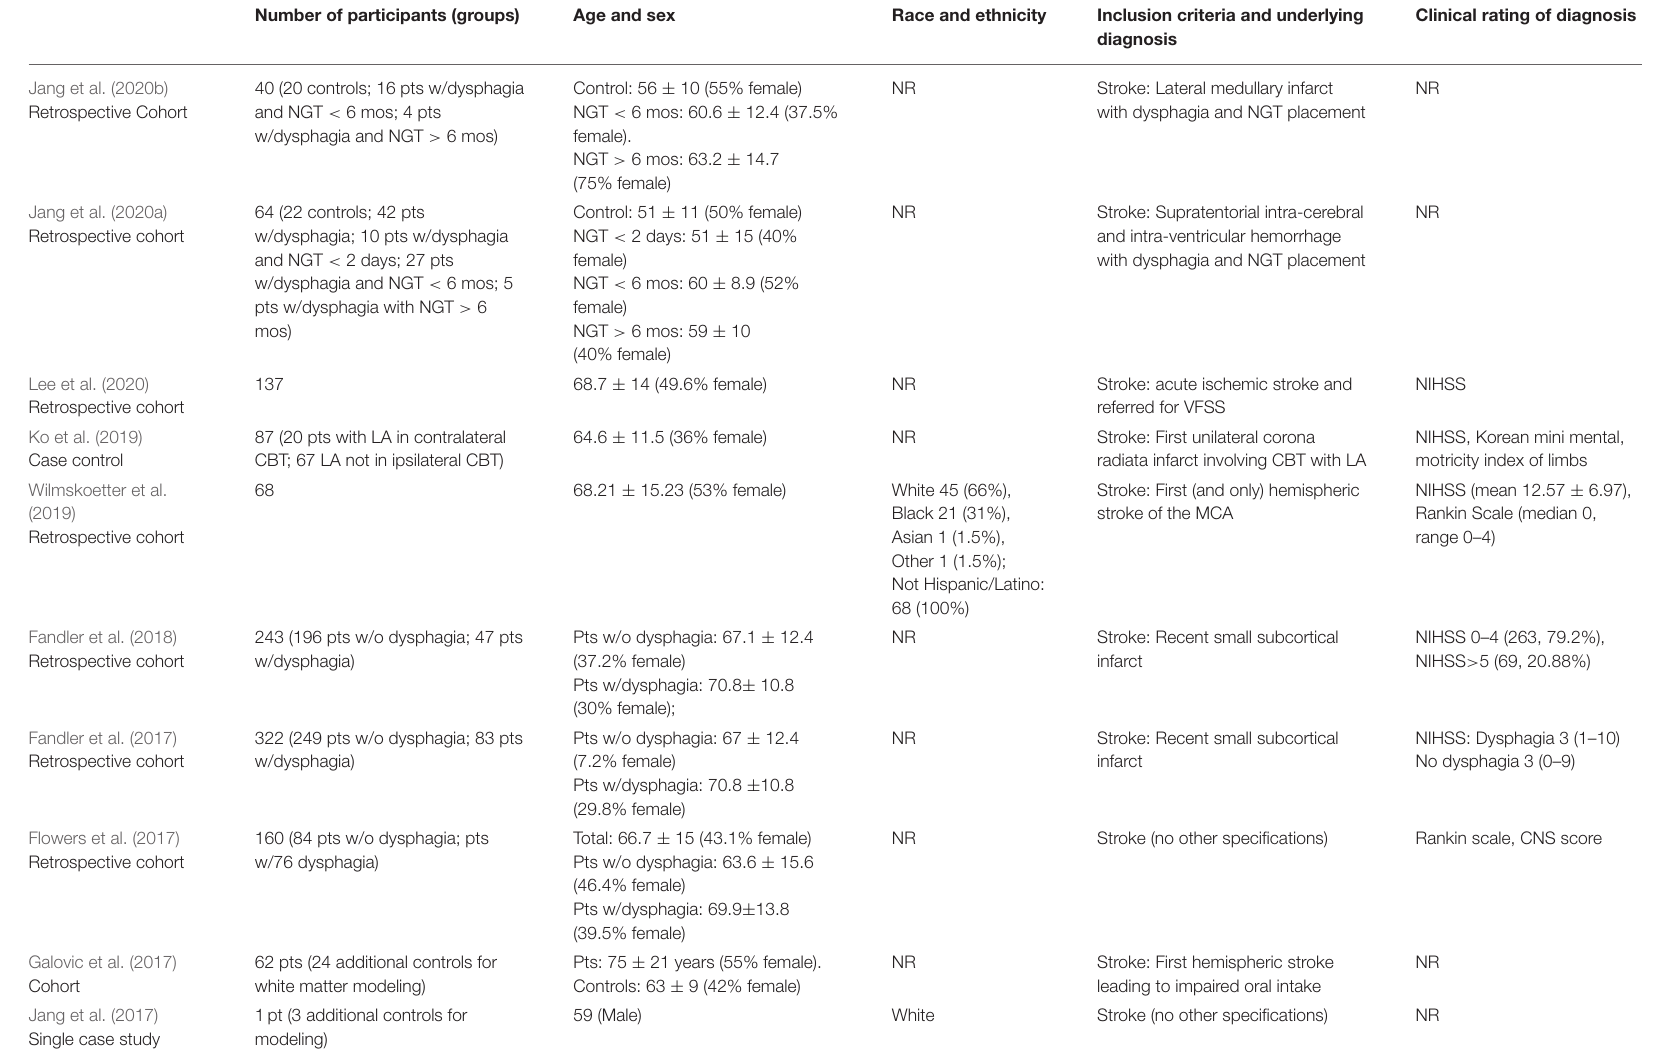
TABLE 2 | Demographics and participant characteristics across